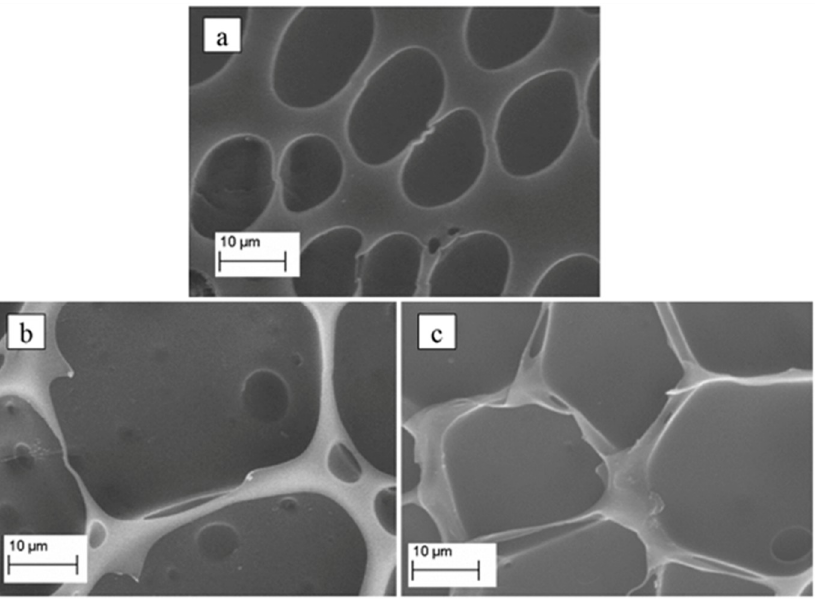
Figure 1. Micrographs of porous ( a ) PDLLA, ( b ) PDLLA/VAMWCNT-O:nHAp1, and ( c ) PDLLA/VAMWCNT-O:nHAp2 membranes.